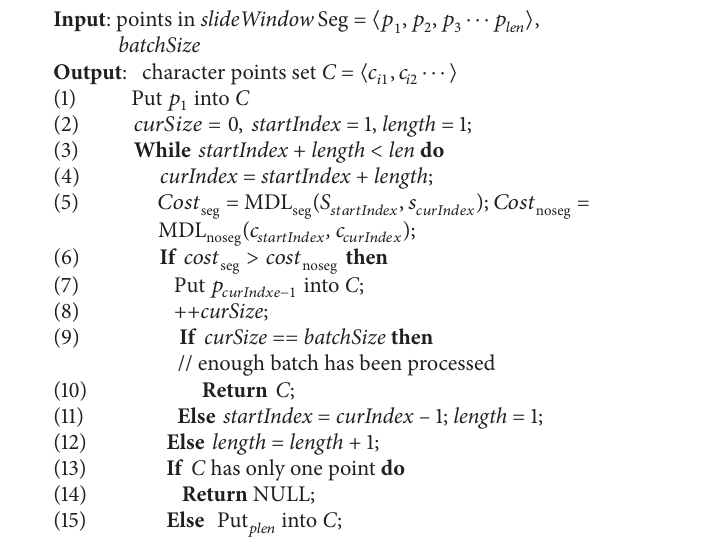
Algorithm 1: Segment in slide window.